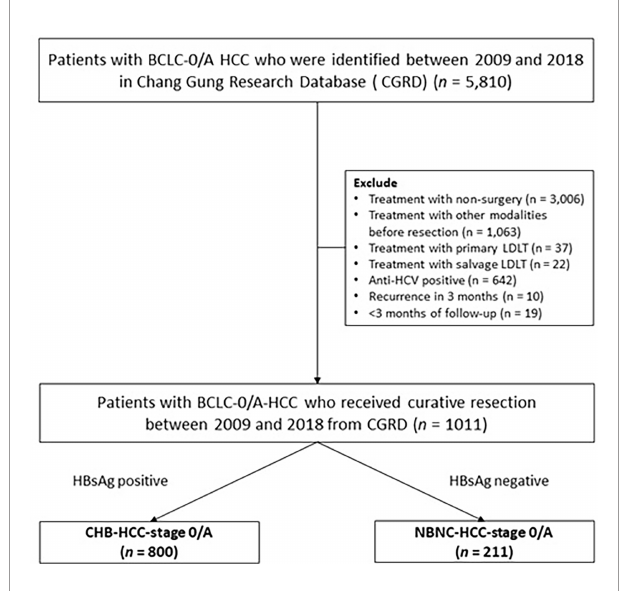
TABLE 1 | Characteristics of the CHB-HCC and NBNC-HCC